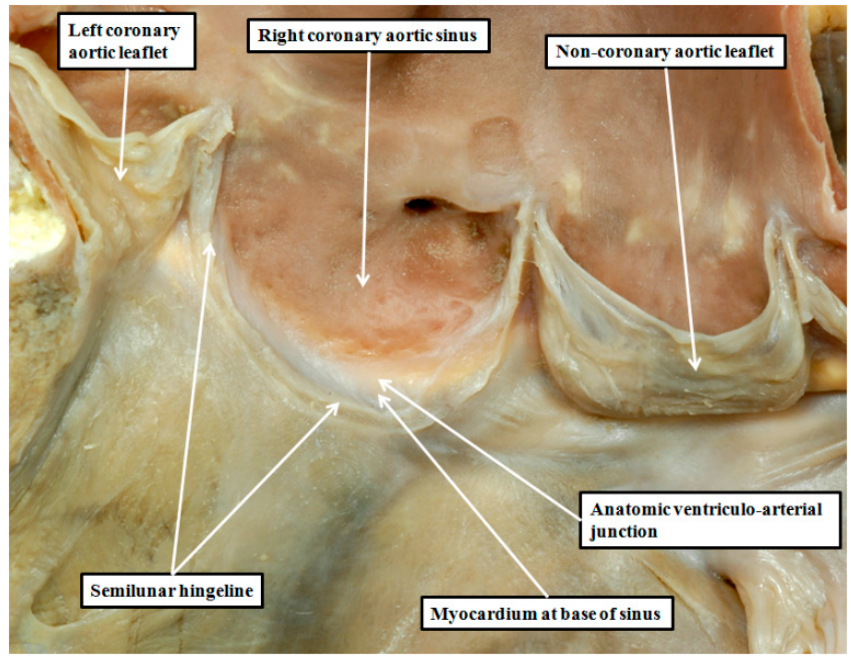
Figure 2. The image shows the aortic root of a normal heart opened by a cut though the left coronary aortic sinus, and viewed from the front. The leaflet guarding the right coronary aortic sinus has been removed, revealing its semilunar line of attachment. The hingeline crosses proximally beyond the anatomic ventriculo-arterial junction, thus incorporating a crescent of myocardium in the base of the sinus.